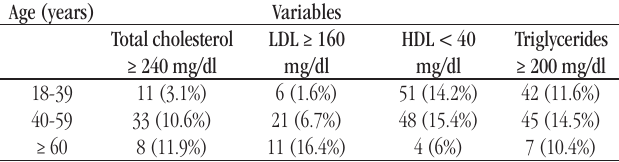
table 3 − Frequency of changes in lipid profile in age